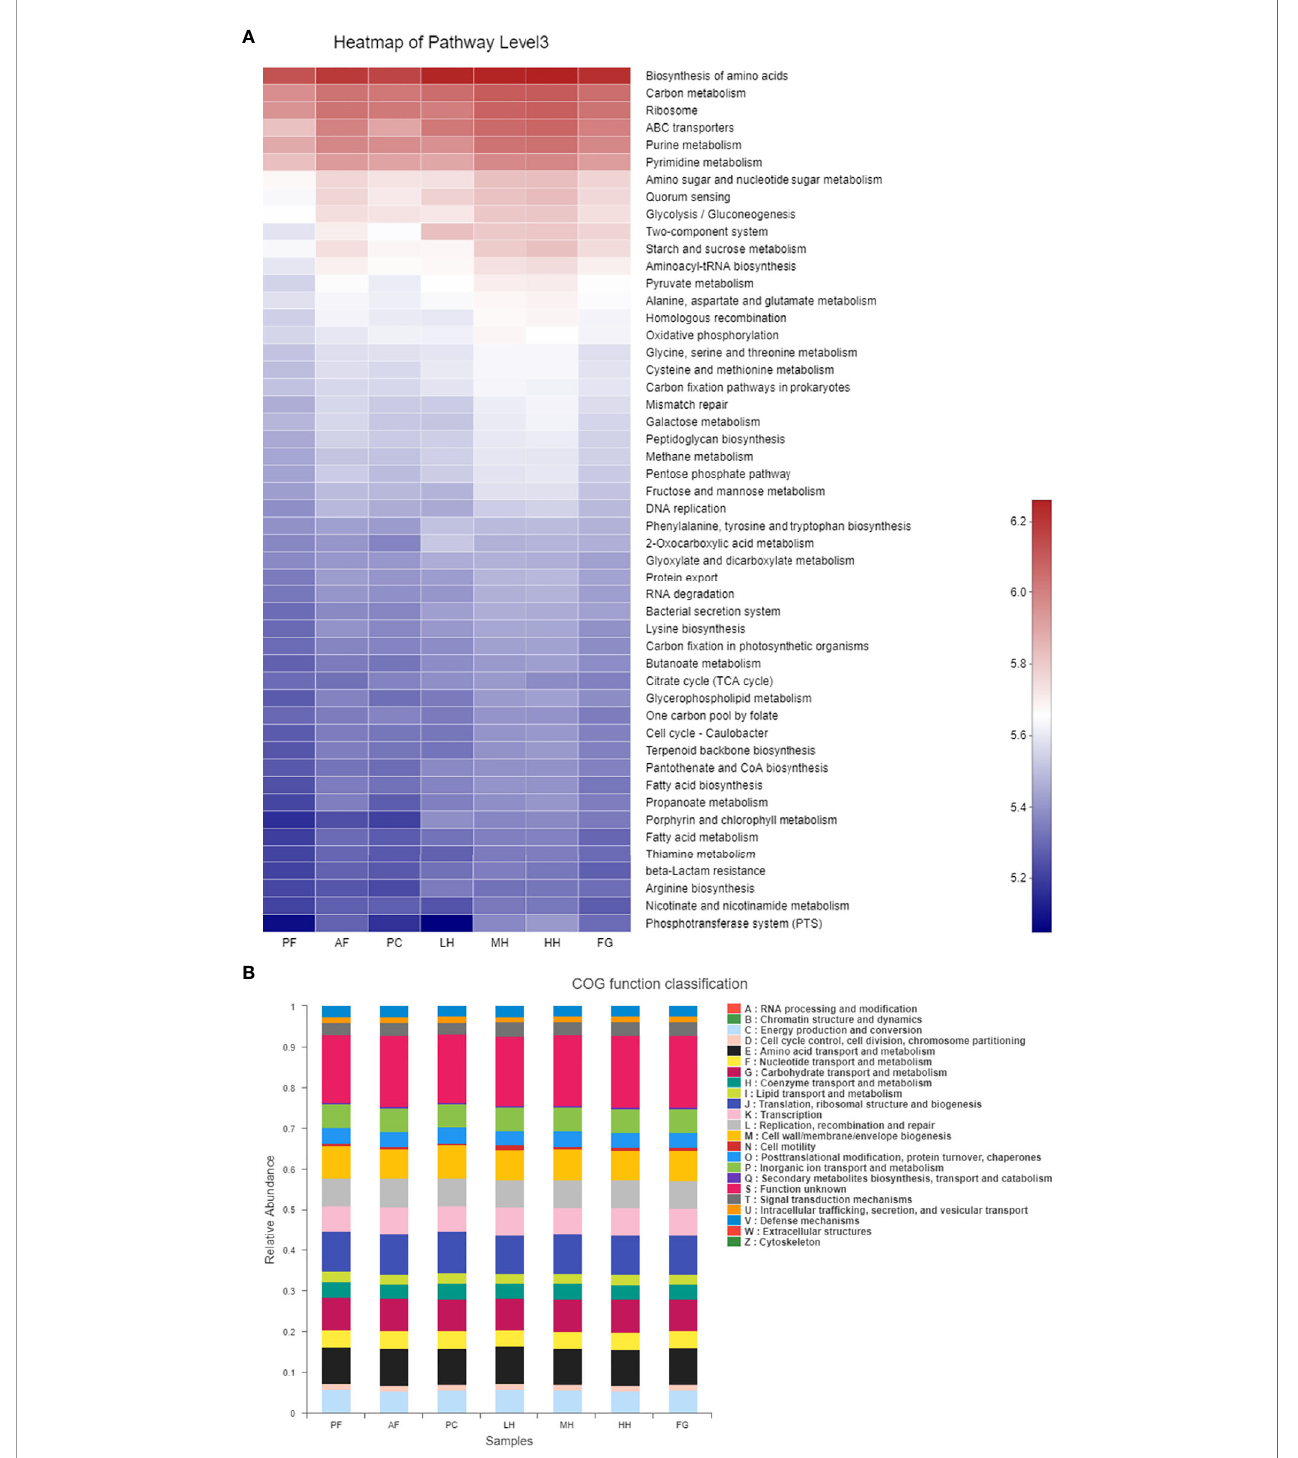
FIGURE 6 | Heatmap of key pathways in KEGG database at level 3 based on PICRUSt predicted functions of the gut microbiota, the colors range from blue to red (A) . The relative abundances of the gut microbiota in COG function classi fi cation (B)